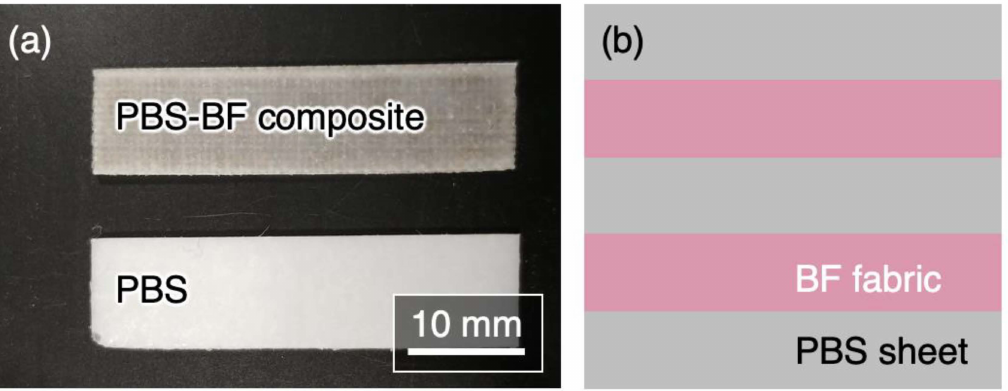
Figure 1. ( a ) Appearance of the PBS–BF composite and the PBS sheets and ( b ) schematic illustration of PBS/BF/PBS/BF/PBS cross-sectional structure.